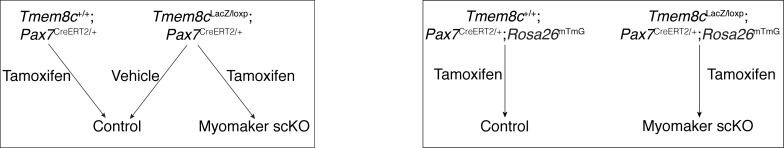
Schematic showing the mice used to ablate myomaker in satellite cells, and their associated control groups.